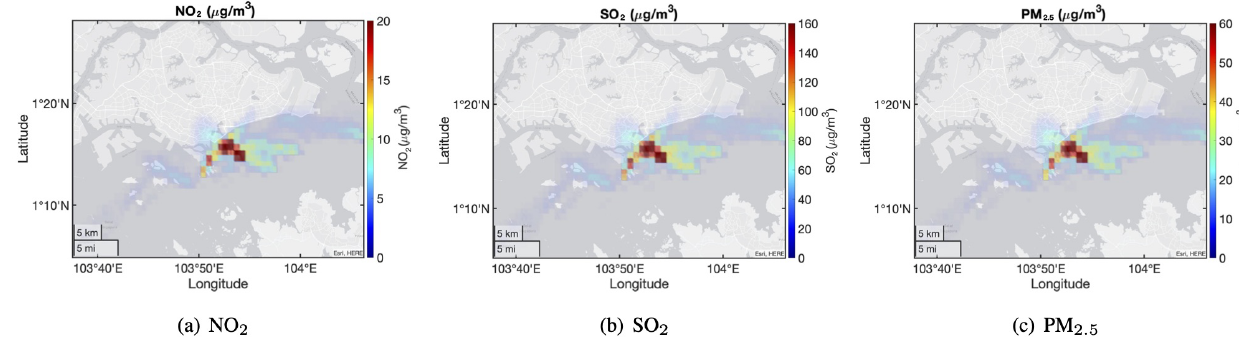
Figure D1. Predicted emission concentrations for different species when using the MPS